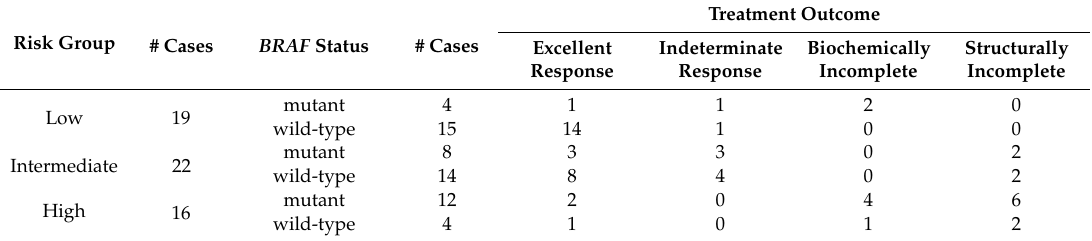
Table 3. Response to the treatment related to risk classification and cf BRAFV600E detection.